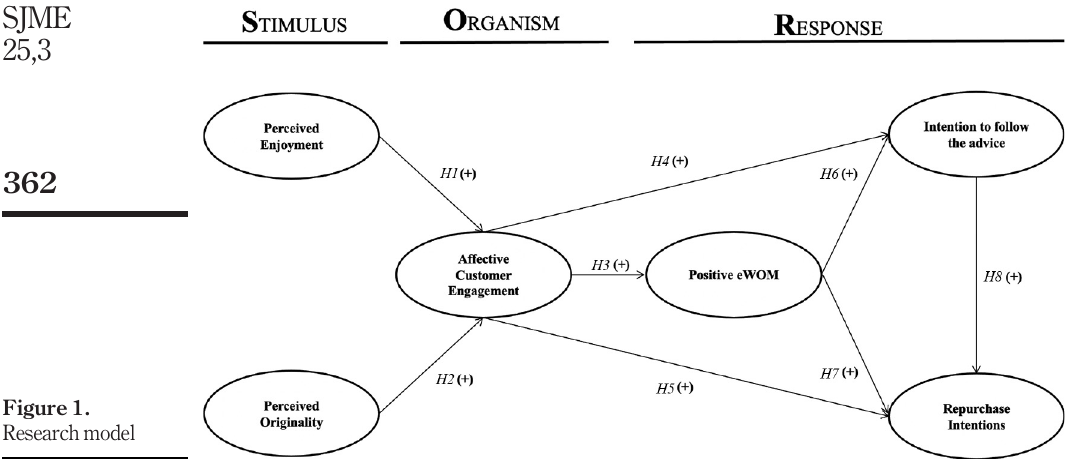
Figure 1. Research